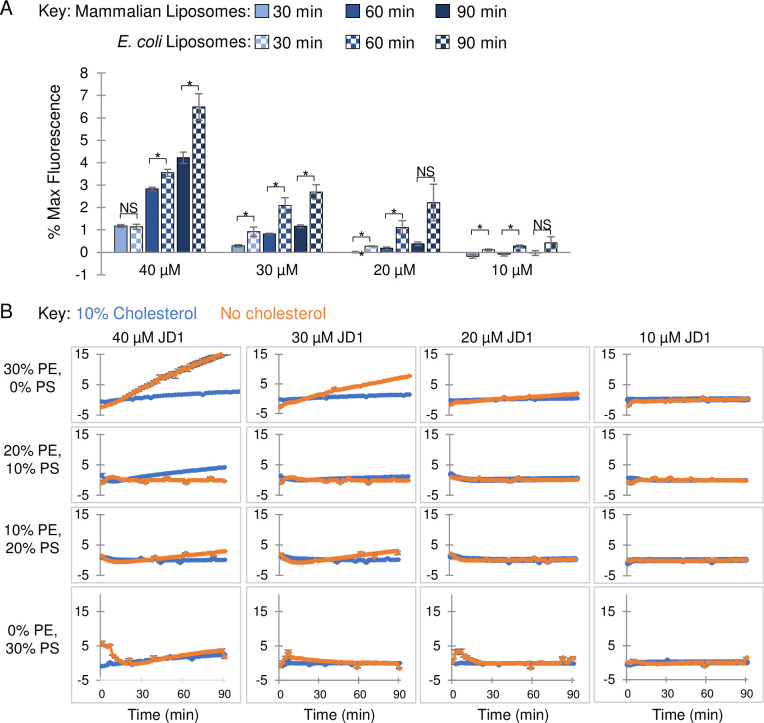
In the presence of the neutral lipid PE, cholesterol protects liposomes from damage caused by JD1.A) Liposomes with phospholipid content similar to mammalian (60% PC, 20% PE, 10% PS, 10% cholesterol) or E. coli (67% PC, 23% PG, and 10% CL) membranes were loaded with the fluorescent probe sulforhodamine B. Liposomes were treated with the indicated concentrations of JD1 or with control DMSO and monitored for fluorescence over a 90 minute period. Data are normalized to DMSO. Student’s t-tests comparing the two indicated samples, * P ≤0.05, ** P ≤0.005. B) Liposomes composed of 60% or 70% PC with 10% or 0% cholesterol, respectively, and with PE and PS concentrations ranging from 0–30% or 30–0%, respectively were exposed to JD1 and examined for sulforhodamine B release. Averages and SEM of three biological replicates performed with technical triplicates.